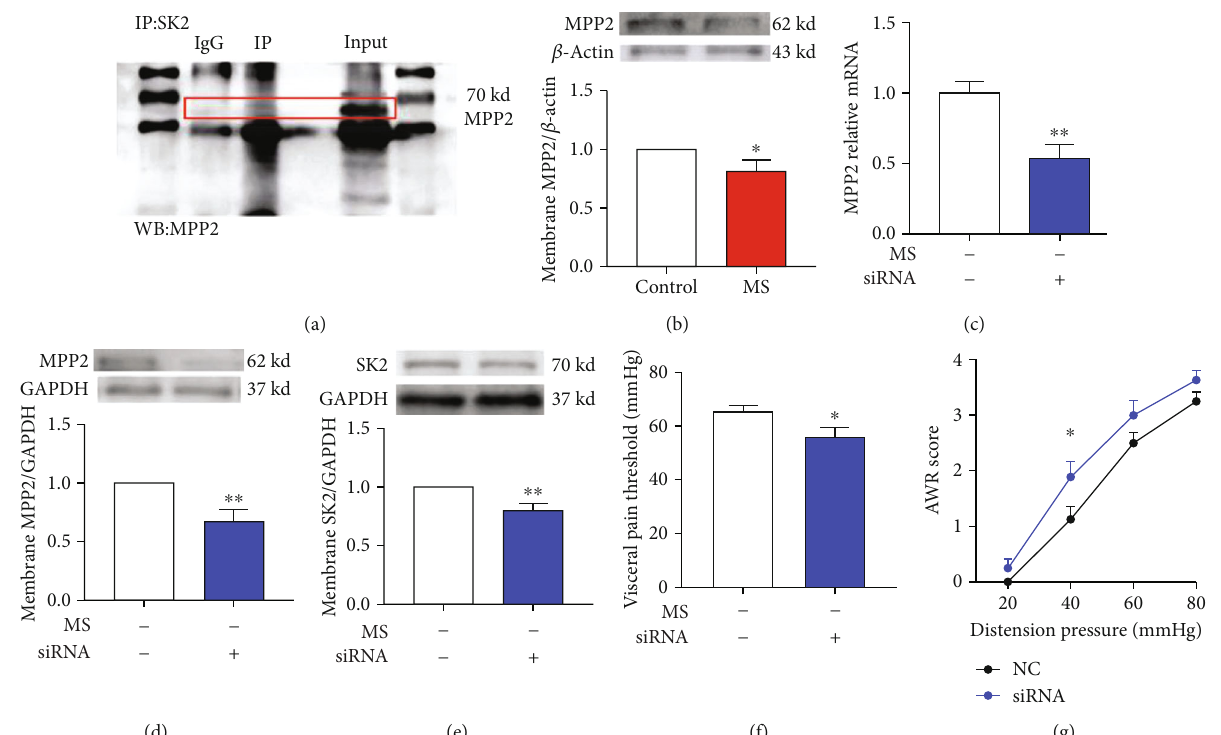
Figure 8: The downregulation of MPP2 contributed to the decrease in the membrane SK2 channel protein and visceral pain threshold. (a) From western blotting of spinal cord cell lysates expressing anti-MPP2 antibody and immunoprecipitation with SK2 or IgG (control), adjacent blotting showed input of MPP2. (b) Spinal MPP2 protein in the membrane fraction presented a signi fi cant decrease in mice experiencing neonatal MS versus the control mice ( t -test, t = 2 : 25 , P < 0 : 05 , n = 6 per group). (c) Spinal MPP2-related mRNA presented a signi fi cant decrease following the siRNA targeting MPP2 administration ( t -test, t = 3 : 56 , P < 0 : 01 , n = 6 per group). (d) The siRNA targeting MPP2 injection resulted in the decrease of spinal membrane MPP2 protein in naïve mice ( t -test, t = 3 : 59 , P < 0 : 01 , n = 6 per group). (e) The siRNA targeting MPP2 administration led to the decrease of spinal SK2 channel in the membrane fraction ( t -test, t = 3 : 54 , P < 0 : 01 , n = 6 per group). (f) The visceral pain threshold in naïve mice presented a signi fi cant decrease after injection of the